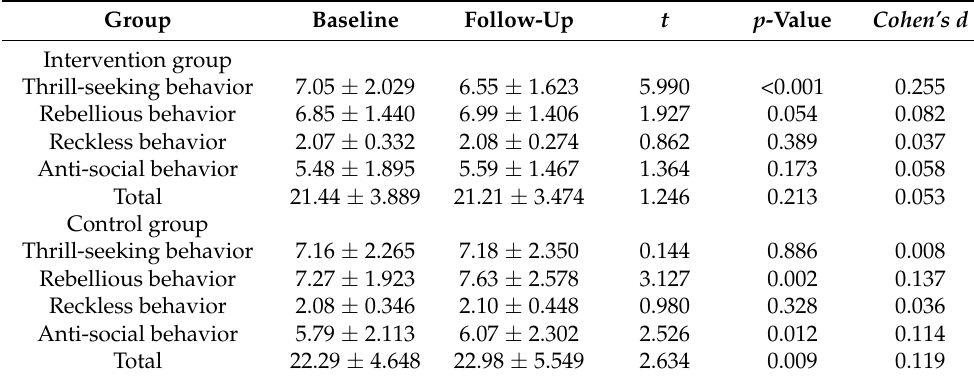
Table 5. Comparison of Adolescent Risk-taking Questionnaire–Risk Behavior Scale (ARQ-RB) scores before and after intervention in both intervention and control